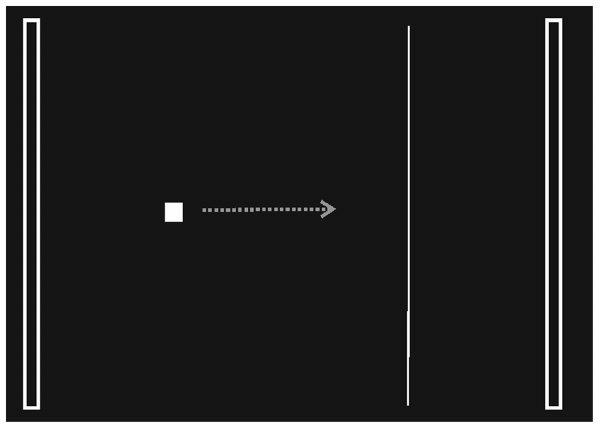
Figure 1. Schematic illustration of the anticipation of move- ment task. A white square moves horizontally towards a target at slow or fast speed but vanishes before reaching it. A white vertical line marks the vanishing point on 50% of the trials. Subjects are required to indicate anticipated time of arrival by button press.